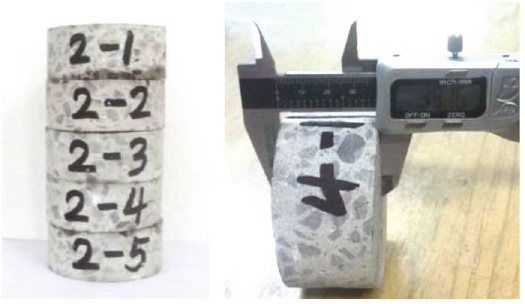
Figure 1: Partial sample.